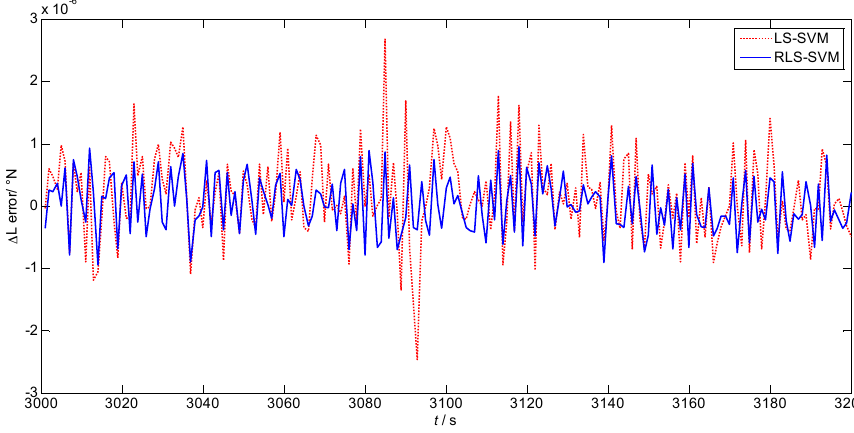
Figure 5. Prediction error of the position increment in latitude.